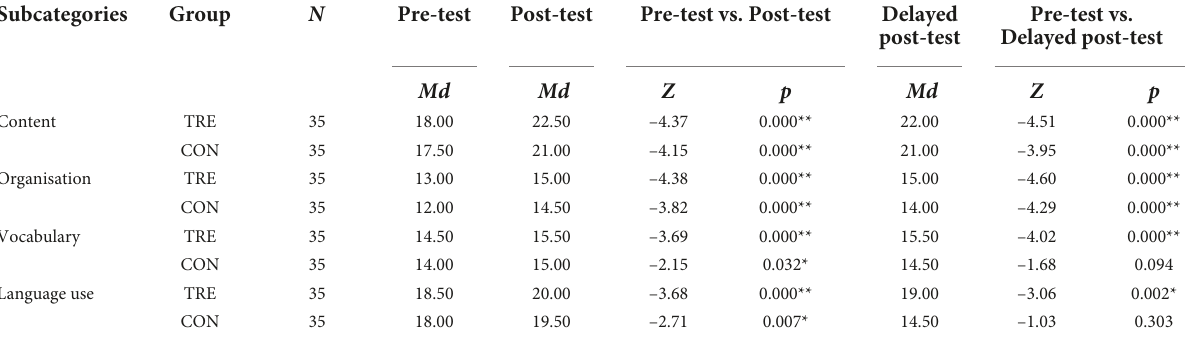
TABLE 7 Descriptive statistics and results of Wilcoxon signed rank tests of analytic writing scores for the treatment and control groups in the pre-, post-, and delayed post-tests. Subcategories